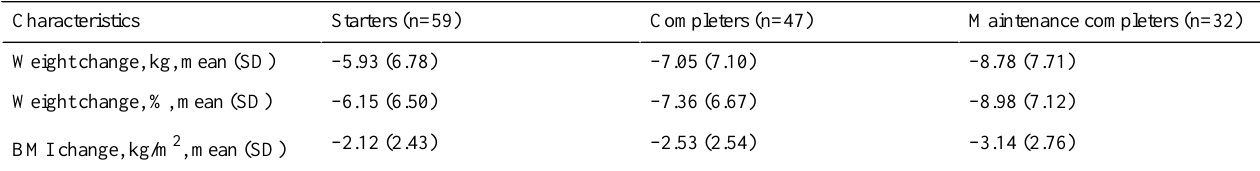
Table 2. Weight loss from baseline to 65 weeks, P <.001. BMI: body mass index.